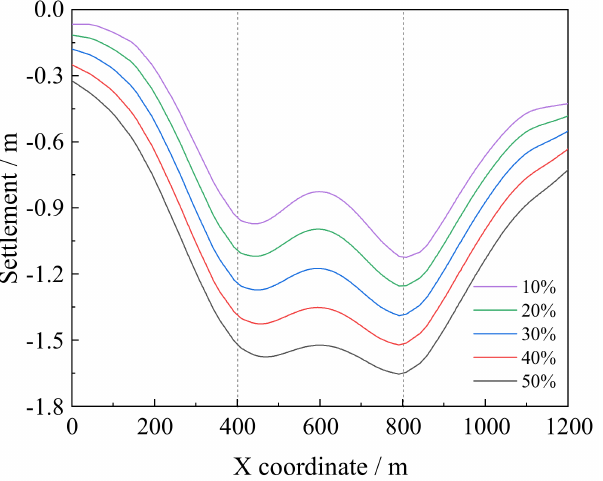
Figure 13. Settlement curves corresponding to different initial saturations of the reservoir.